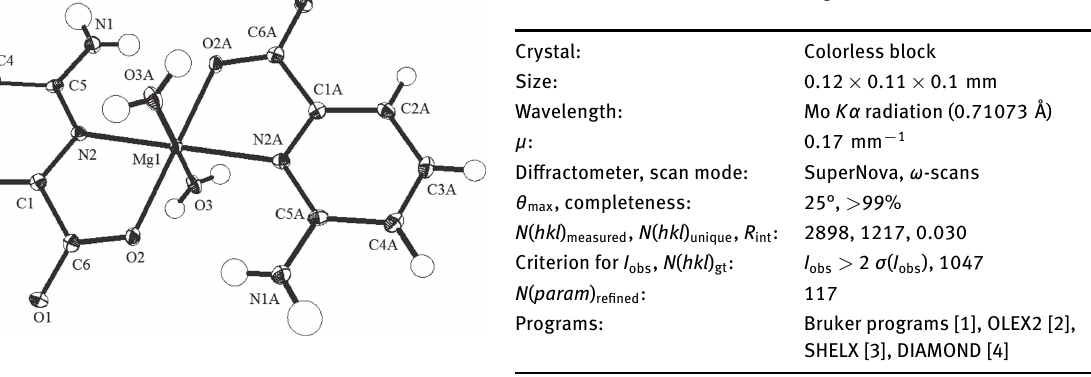
Table 1: Data collection and handling.